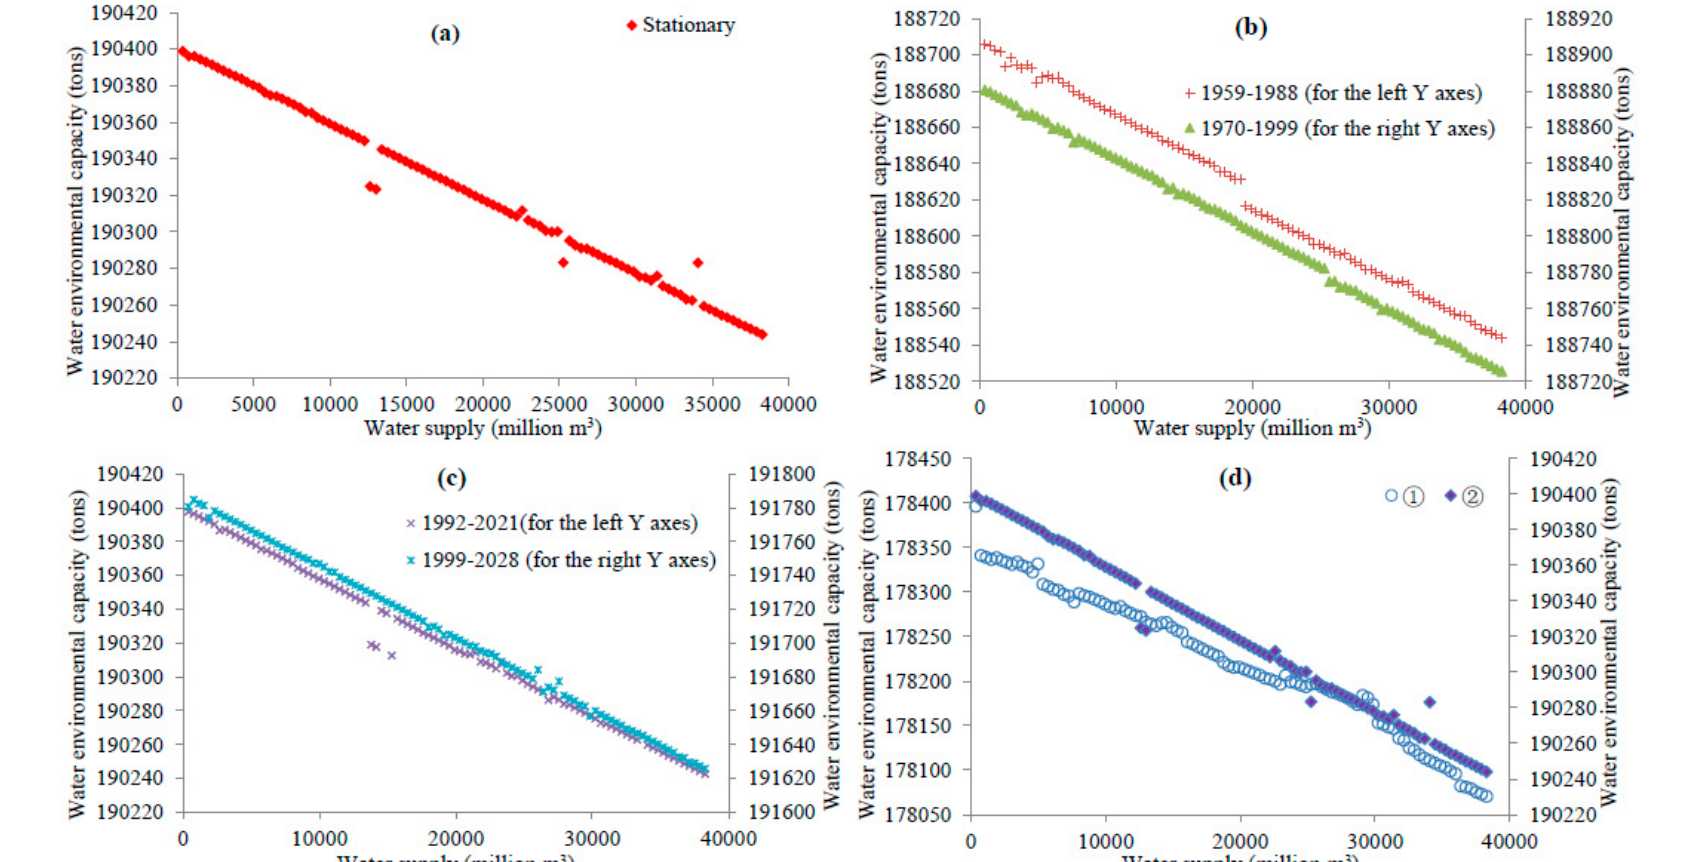
Figure 5. Supply-water environmental capacity nexus under the changing upstream boundary conditions: ( a )–( c ) the salt intrusion water can increase the water environmental capacity under the different boundary conditions; ( d ) the Comparison between salt intrusion water increase (indicated by “ ① ” for the left Y axes) and cannot increase (indicated by “ ② ” for the right Y axes) the water environmental capacity under the stationary boundary conditions.